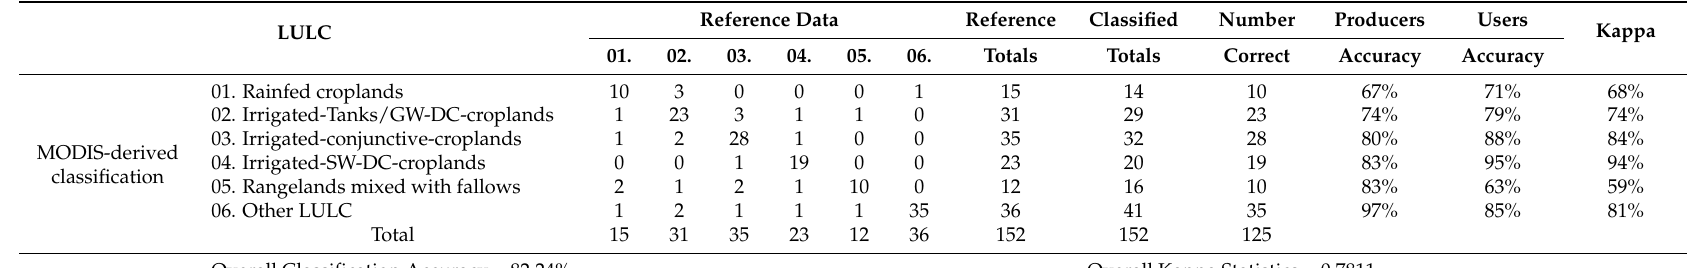
Table 5. Accuracy assessments done using error matrix for LULC classes of 2013–2014.